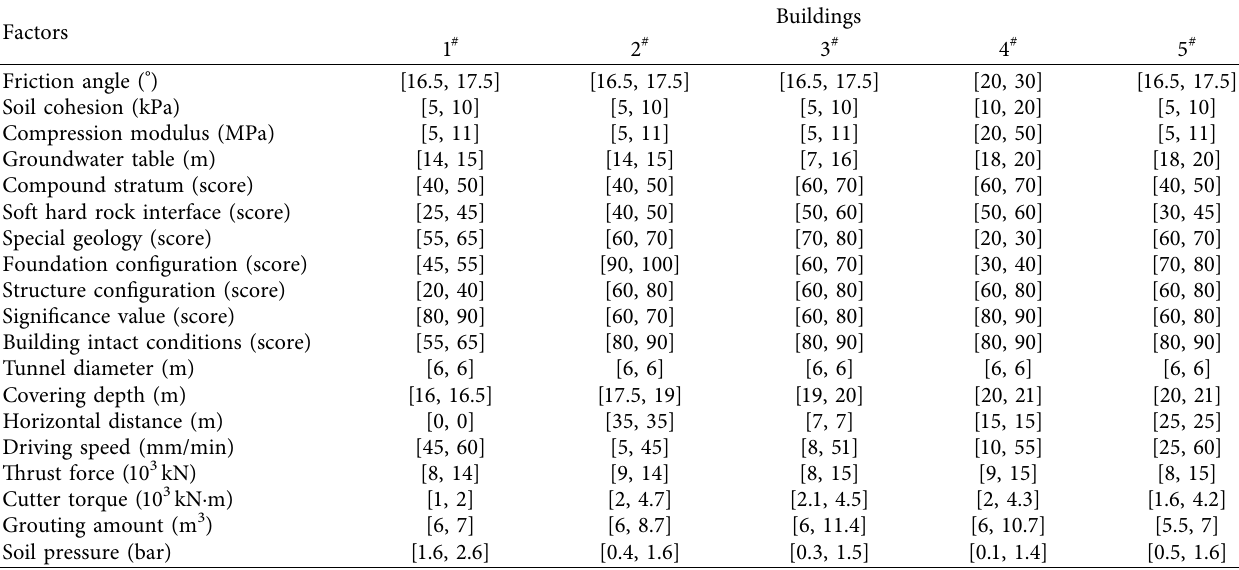
Table 3: Values of 19 evaluation factors for 5 adjacent buildings.